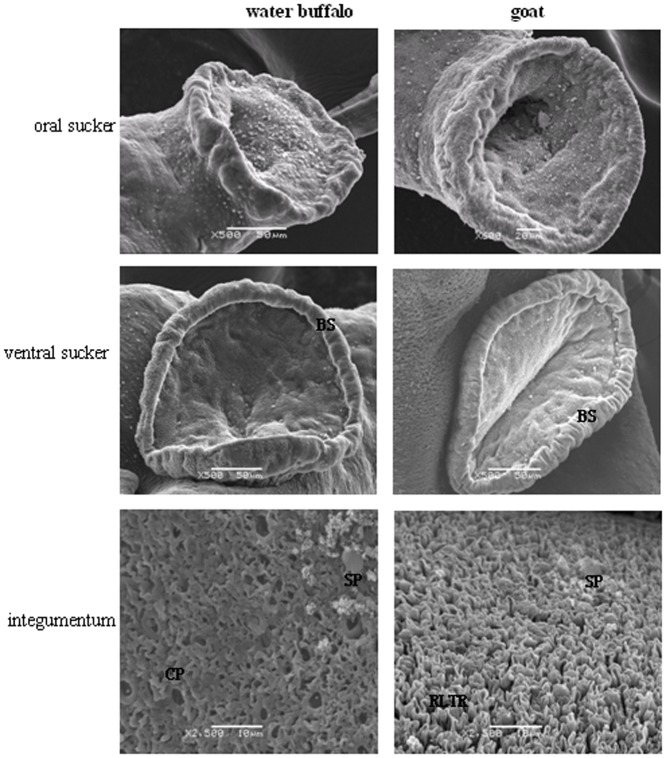
Comparisons of the oral suckers, ventral suckers, and the integument of male worms derived from water buffalo and goats by SEM.BS, border spine; CP, cortical pore; RLTR, rope-like tegumental ridge; SP, sensory papillae.